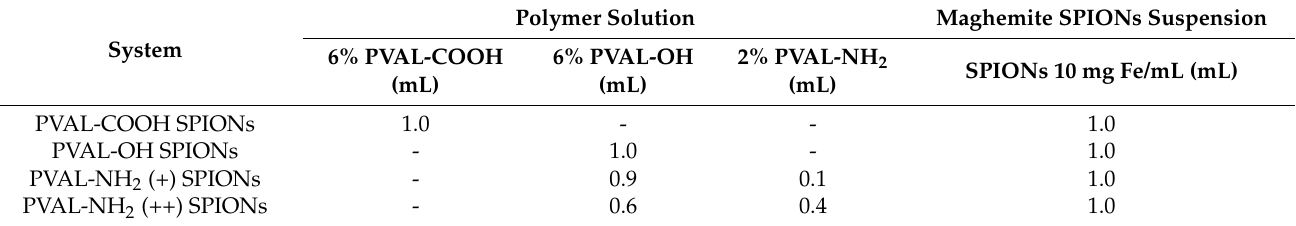
Table 6. Summary of SPIONs coating preparation with a corresponding volume of polymer